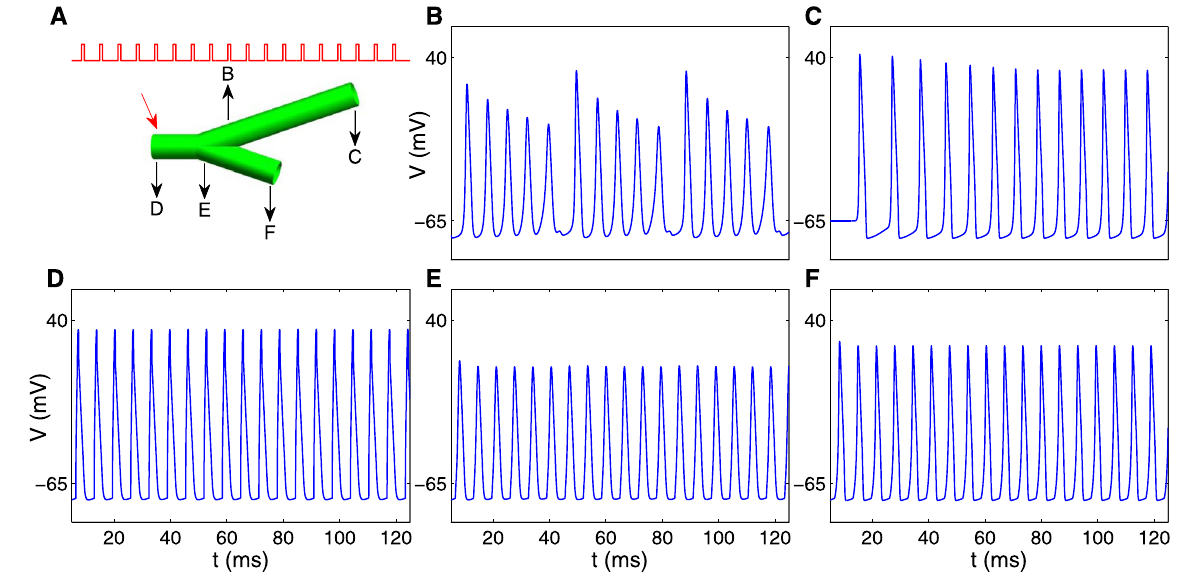
Figure 5. Example response to current stimuli along an asymmetric branched axon. ( A ) A schematic diagram of an asymmetric branched axon composed of daughter branches with identical radii and different lengths. Red arrow indicates the current stimulation point. Stimulus signal is represented by red line (154 Hz). ( B – F ) show the propagating signal dynamics measured in the points indicated by black arrows in ( A ), D at the stimulus point, B and C on the long branch 0.3 cm and 3 cm downstream of the branching point respectively, and E and F on the short branch 0.01 cm and 0.1 cm downstream of the branching point respectively. The system was set with a mother branch radius of 10 µ m, GR of 1, and mother and daughter branch lengths of 0.1 cm, 0.1 cm, and 3 cm